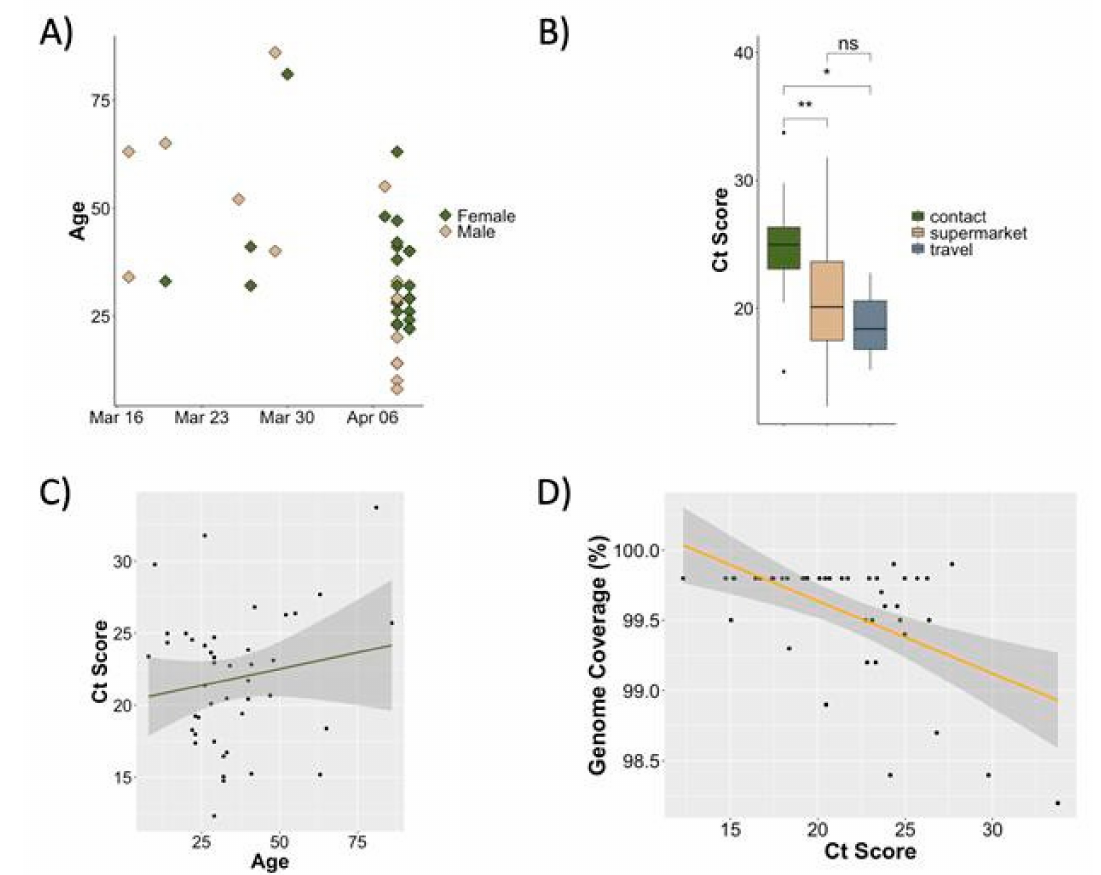
Figure 2. SARS-CoV-2 samples. ( A ) Scatter plot of samples obtained for this study showing sampling dates, age, and gender of patients. ( B ) Patient exposure status denoting whether patients had any travel history (grey), were part of a supermarket outbreak (brown) or were contacts of known cases (green). The Ct values may correlate with timing of sample collection. ( C ) The relationship between age of patients and Ct score. A p -value less than 0.05, is flagged with one star (*) and a p -value less than 0.01, is flagged with two stars (**) ( D ) The relationship between Ct score and resulting genome coverage after sequencing, showing higher overall genome coverage (hence sequence quality) from samples with lower Ct scores (higher viral